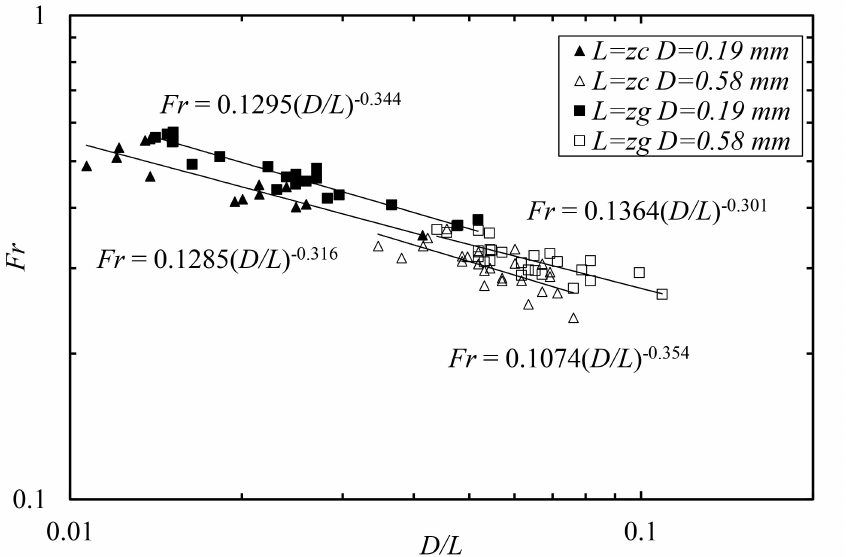
Figure 4. The dimensionless predictive formula of critical inlet height of particle initial